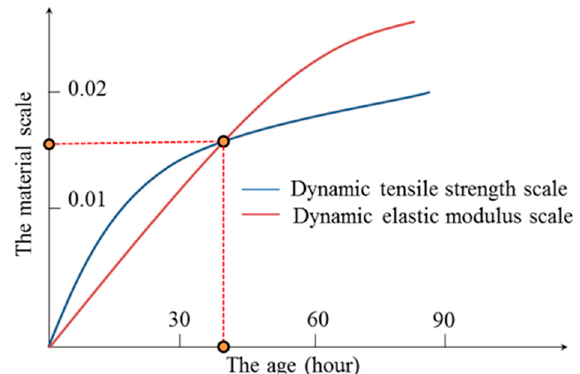
Figure 2. Method for determining the age of the experimental material(s).